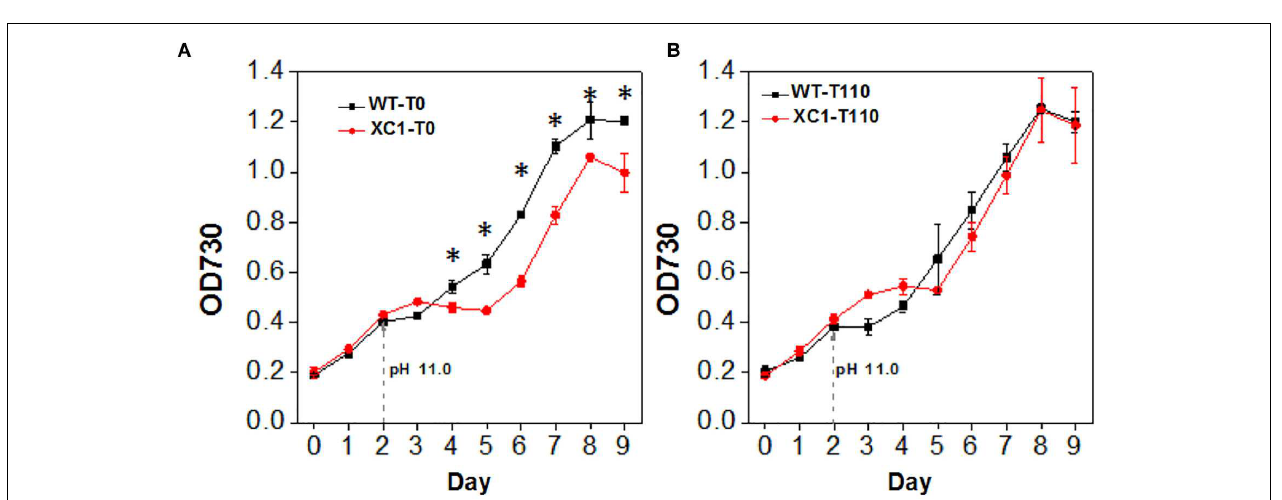
FIGURE 6 | Growth of PCC7942-WT and PCC7942-XC1 facing high pH stress under theophylline concentrations of (A) 0 µ M, (B) 110 µ M. To adjust pH values of the culture medium to 11.0, NaOH would be added in day 2 as the arrow pointed. The OD730 data utilized are averages of measurements from at least three independent biological repeats, and standard deviation bars are also shown. Asterisks’ indicate significant differences between the data of WT and XC1 (Student’s t -test, P <